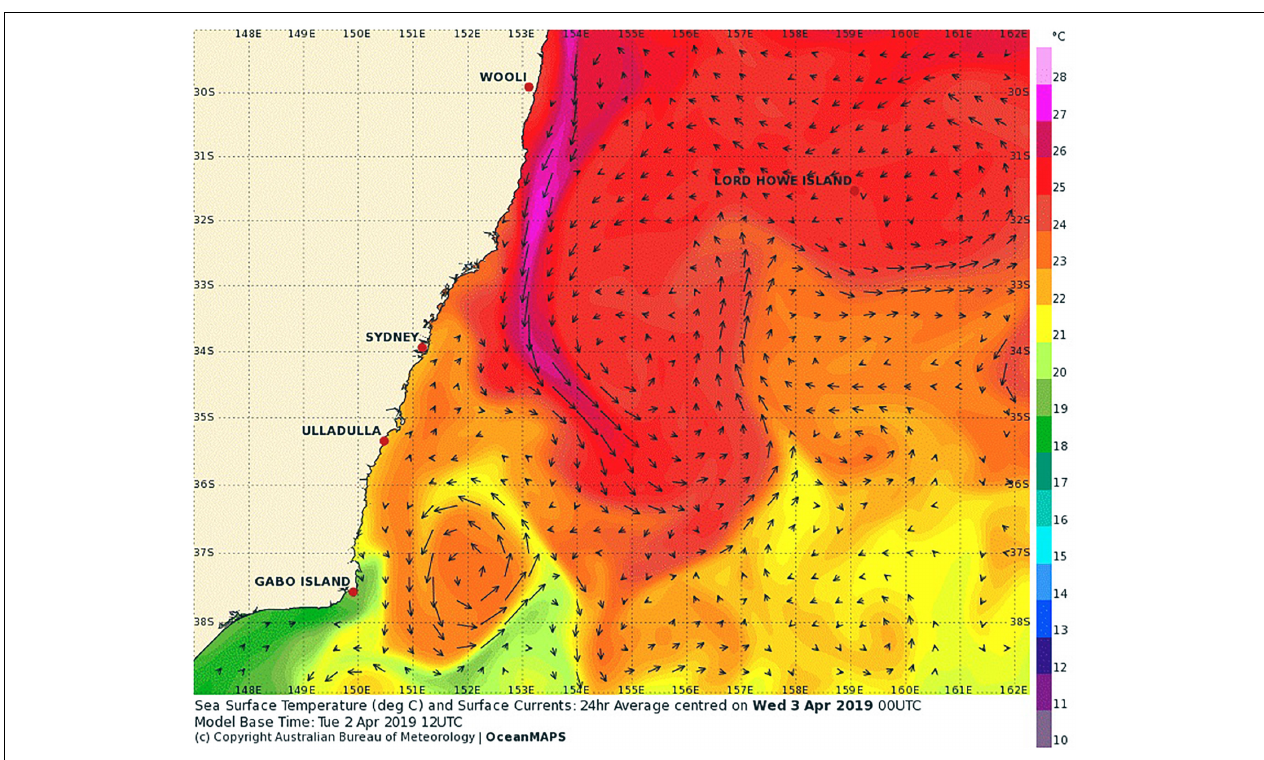
FIGURE 9 | Daily averaged forecast SST and surface currents in the East Australian Current, centered on April 03, 2019, obtained from the Bureau of Meteorology’s operational OceanMAPS ocean model, with a model base time of April 02, 2019 12 UTC. (Sourced from http://www.bom.gov.au/oceanography/forecasts/, accessed on April 03, 2019; reproduced by permission of Bureau of Meteorology, © 2019 Commonwealth of